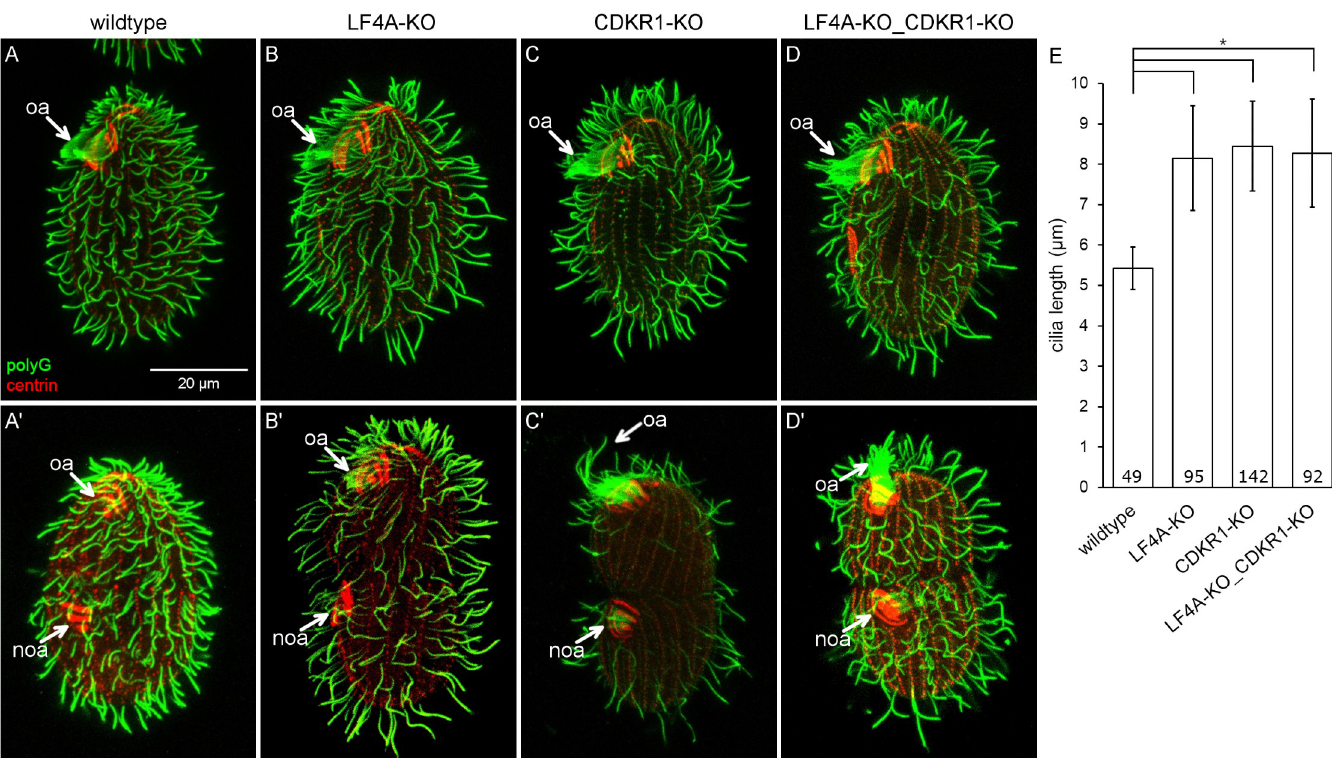
Fig 6. A loss of CDKR1 lengthens both the locomotory and oral cilia. (A-D ' ) Wildtype (A and A ' ), LF4A-KO (B and B ' ), CDKR1-KO (C and C ' ) and double knockout LF4A-KO_CDKR1-KO (D and D ' ) cells that are either in interphase (top panels) or dividing (bottom panels). The cells were stained with the anti-polyG tubulin (green) and anti-centrin antibodies (red). (E) The locomotory cilia lengths in different backgrounds. The cilia length in LF4A-KO, CDKR1-KO and the double knockout strain are similar (p > 0.01) and all are significantly longer than the wild-type cilia (one way Anova, p < 0.01). Sample sizes are indicated, error bars indicate SDs.